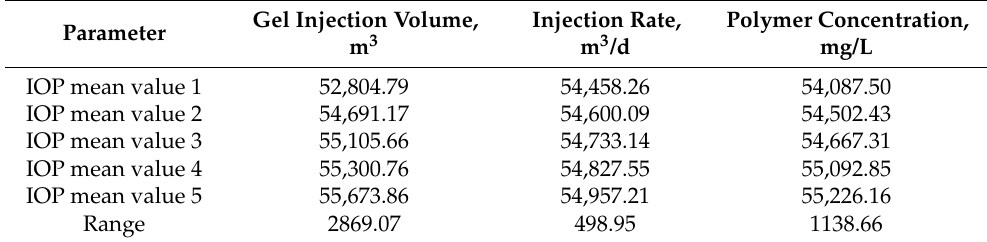
Table 8. The IOP mean value of different parameters and its